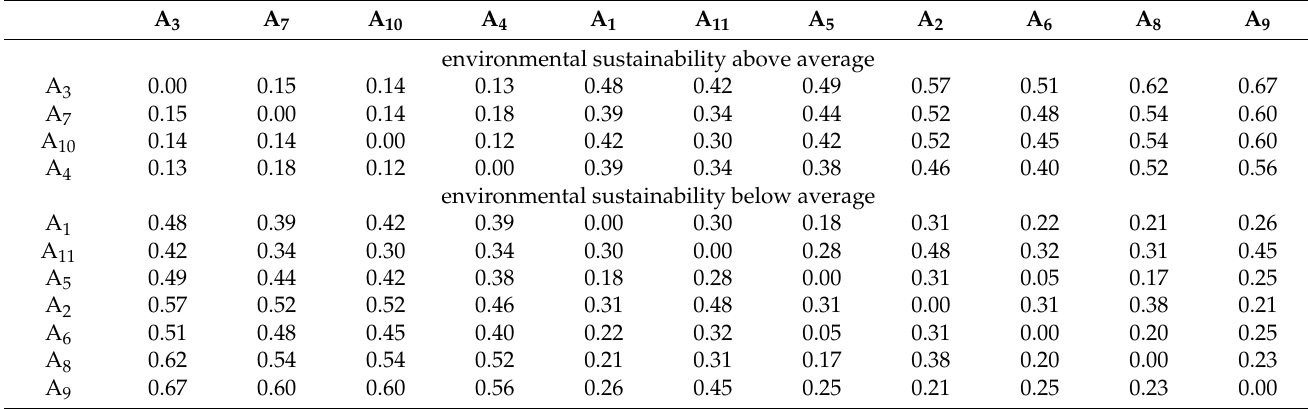
Table 4. Euclidean distances matrix between industrial zones when clustering objects by levels of environmental sustainability according to the criteria K 1 –K 4